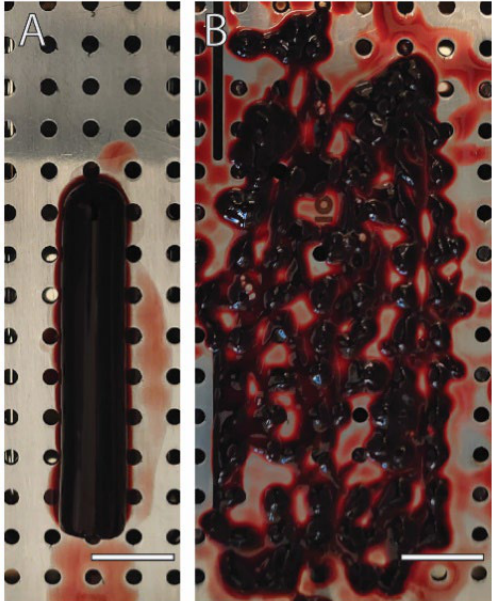
Figure 1. UBC membranes are fragments lacking clinically relevant biomechanical properties. ( A ) Coagulated unfractionated blood forms rods that could be pulled from the plain glass tubes. ( B ) Compression of the UBC on a porous steel plate failed to generate mechanically stable membranes. The pseudo UBC membranes appear as fragments lacking the integrity of a clinically relevant PRF membrane. However, the fragments of the UBC membranes could be harvested and further used in bioassays of TGF- β and anti-inflammatory activity. Scale bars indicate 12 mm.